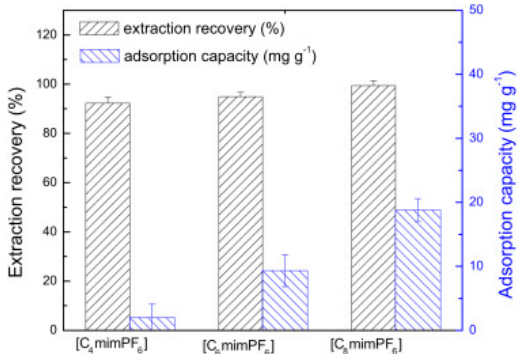
Figure 3. Effect of the kind of extraction solvents on ER of UPA and adsorption capacity. Extraction Figure 3. E ff ect of the kind of extraction solvents on ER of UPA and adsorption capacity.